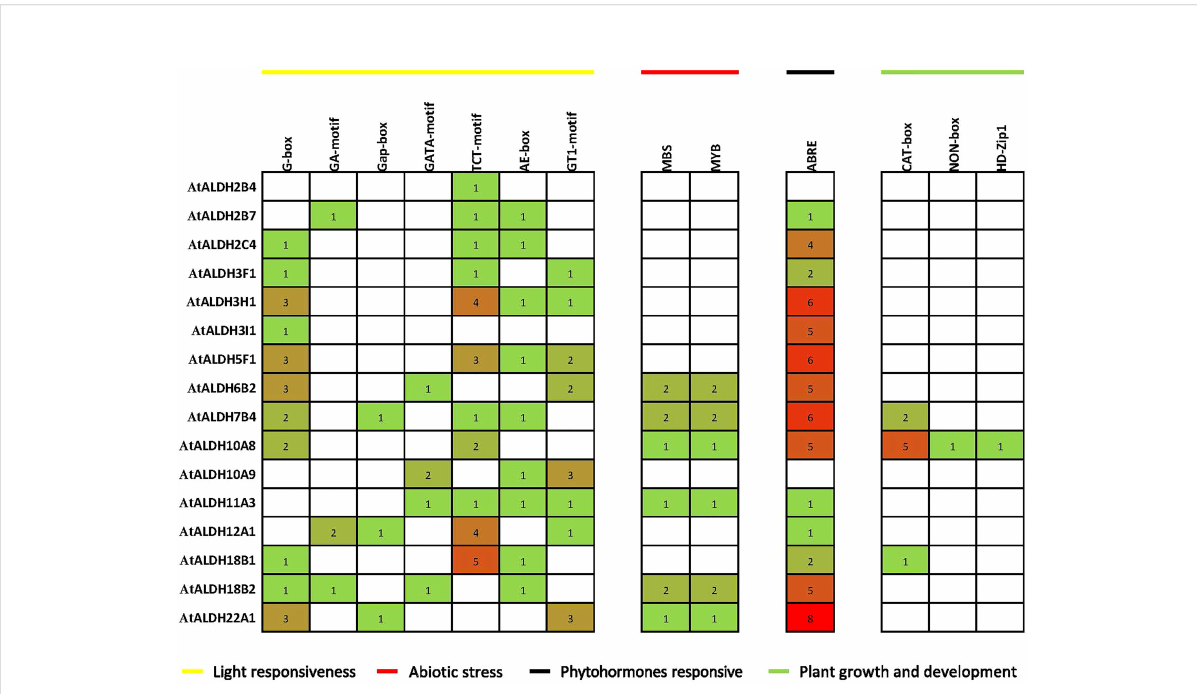
FIGURE 6 Distribution of cis -acting regulatory elements (CRE) in promoter sequences of AtALDH genes. The 1500 bp genomic DNA sequence upstream of the initiation codon (ATG) was extracted from the Eukaryotic Promoter Database (https://epd.ep fl .ch/), potential CREs were analyzed by the PLACE database (http://www.dna.affrc.go.jp/PLACE/signalscan.html). The obtained data were visualized by PowerPoint (https://www.microsoft. com/en-us/microsoft-365/powerpoint). The yellow line indicates light responsiveness CREs; the red line indicates abiotic stress CREs; the black line indicates phytohormone responsive CREs; green line indicates plant growth and development CREs. The number in squares indicates the presence of